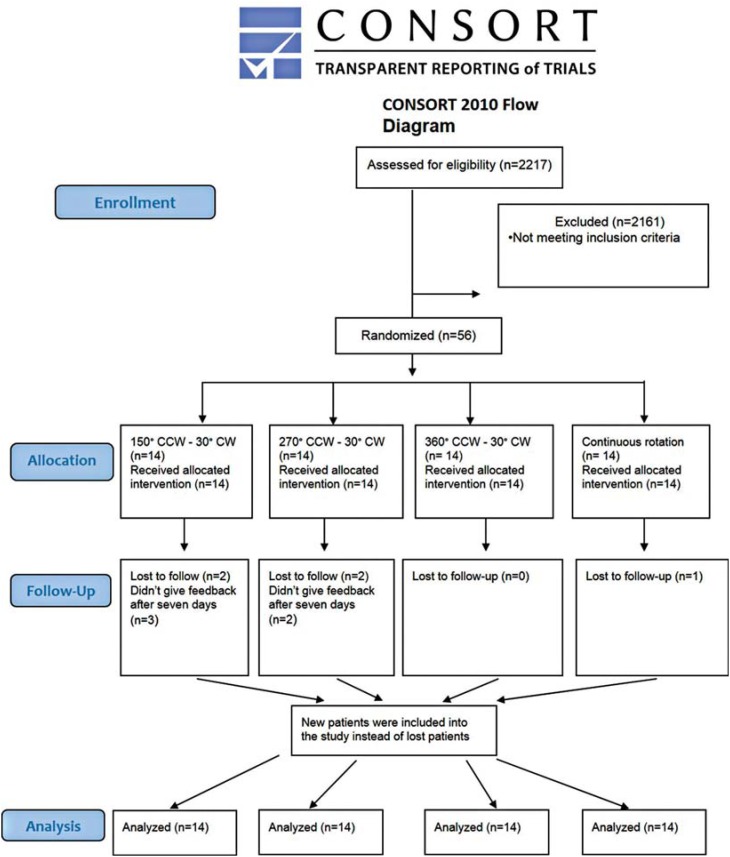
Consort flow diagram